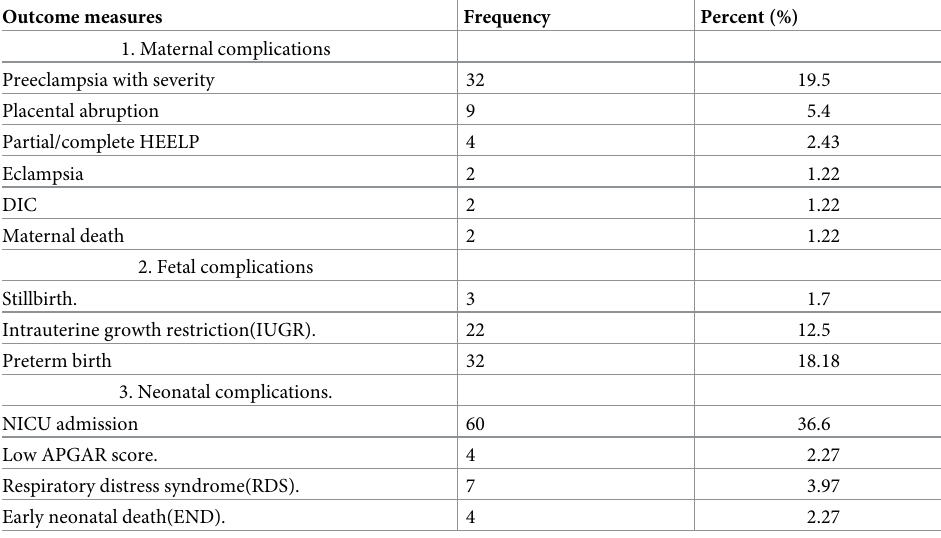
Table 2. Maternal, fetal and neonatal complications of expectantly managed preeclampsia without severe feature at SPHMMC,